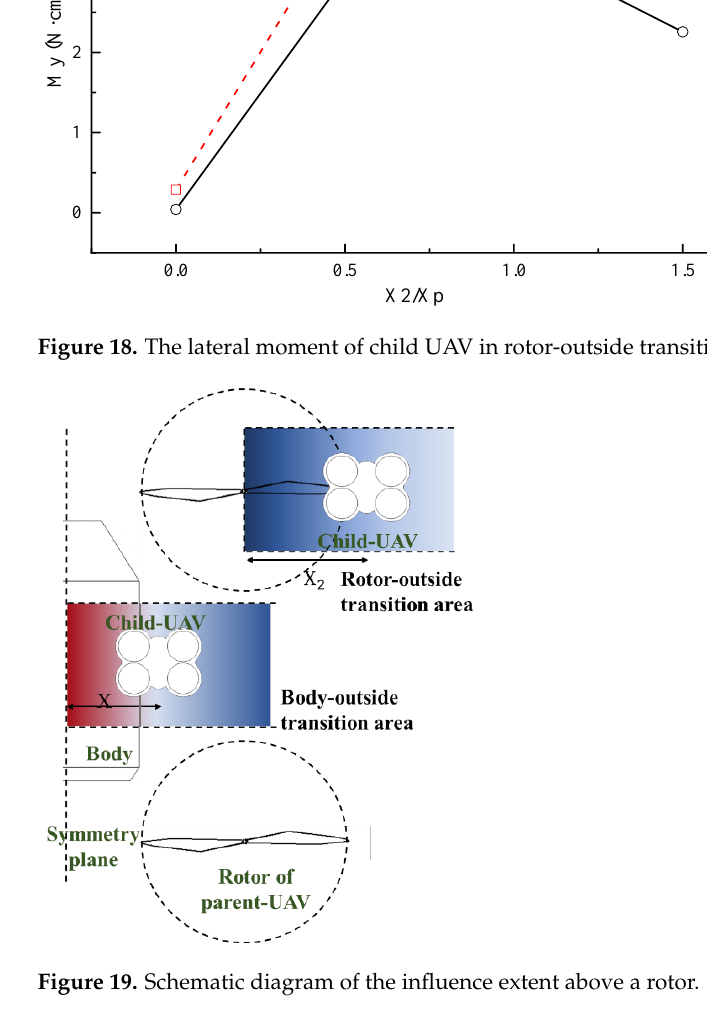
Figure 19. Schematic diagram of the influence extent above a rotor.